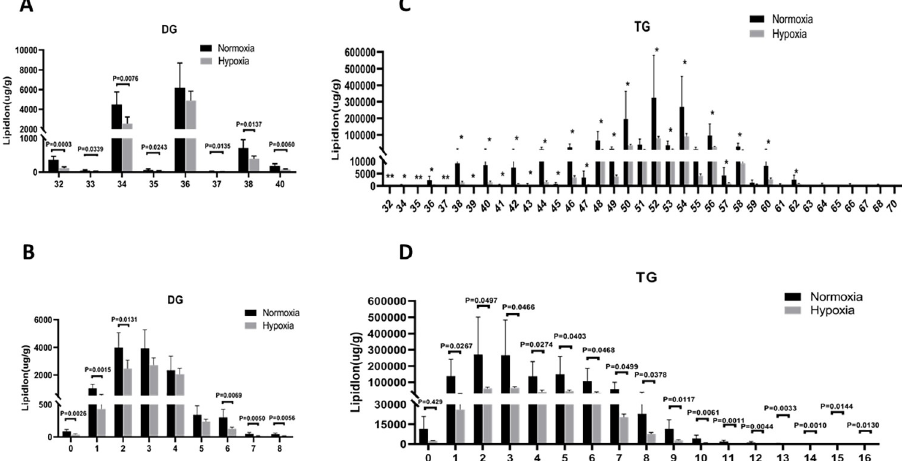
Fig 5. Analysis of significantly different lipids between the normoxia and hypoxia groups. (A) DG carbon chain length analysis. (B) DG saturation analysis. (C) TG carbon chain length analysis. (D) TG saturation analysis. �� p < 0.01 versus the normoxia group; � p < 0.05 versus the normoxia